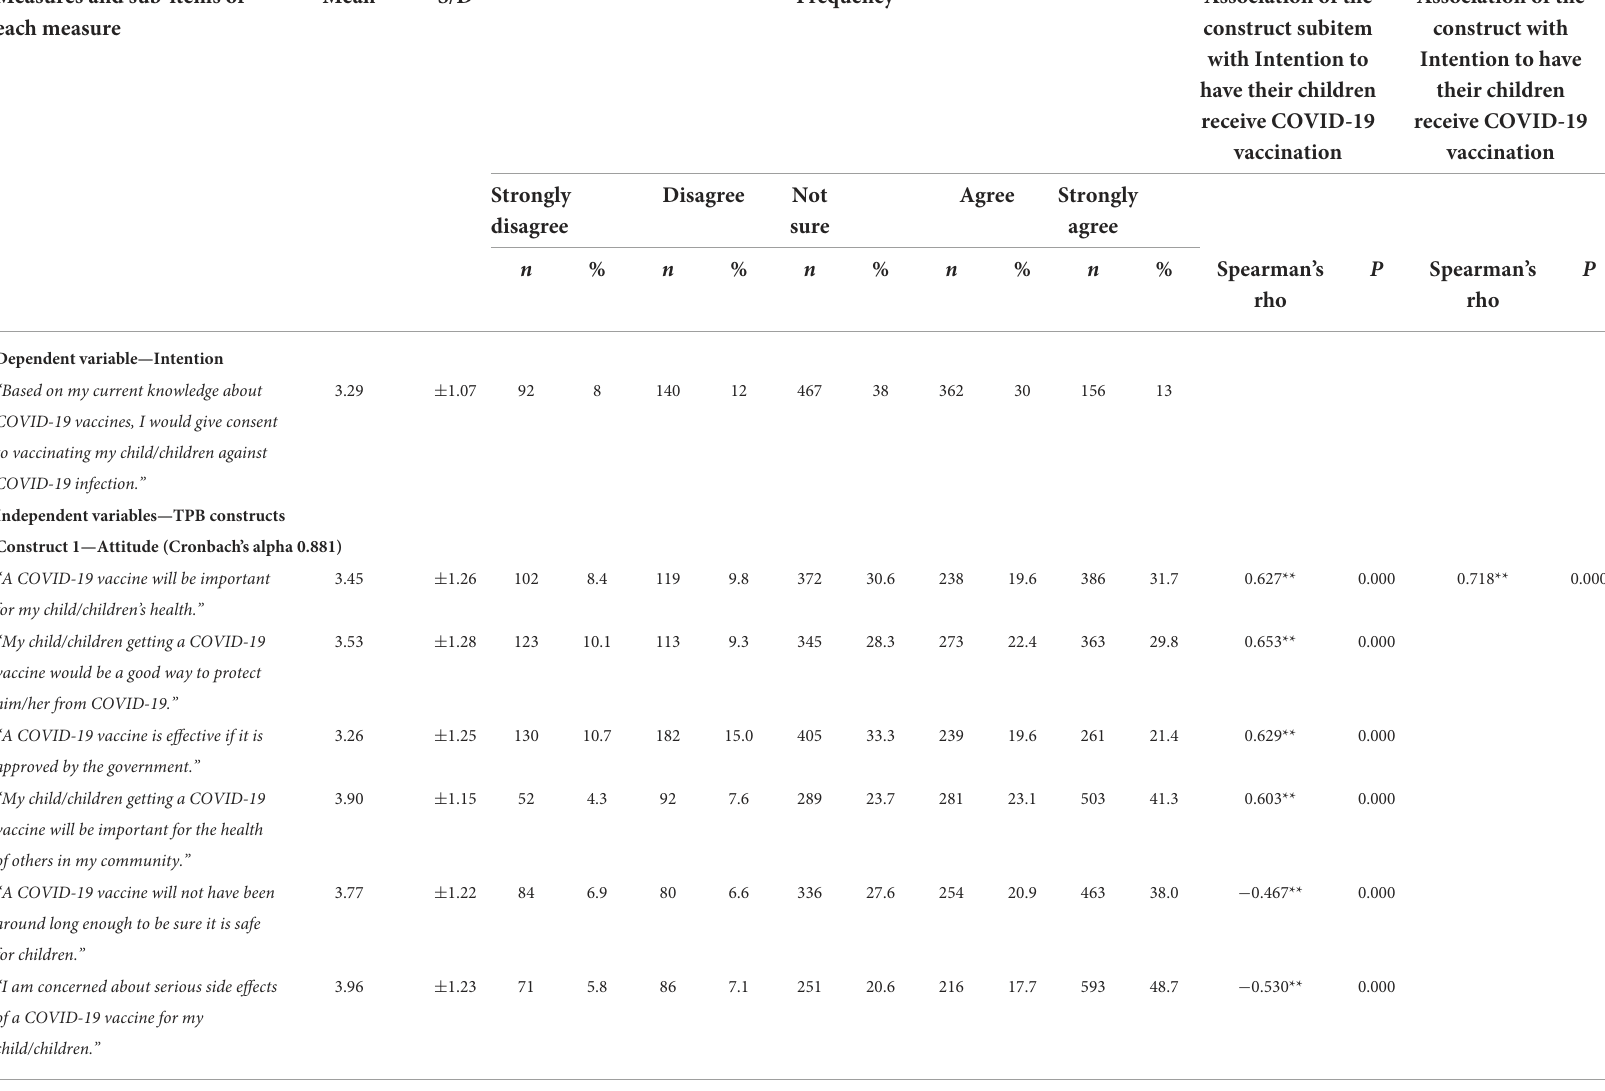
TABLE 2 Measurement of the TPB constructs. Measures and sub-items